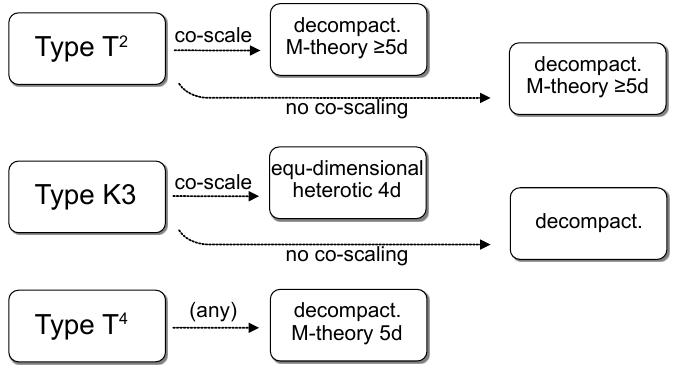
Figure 2 . Basic infinite distance limits in the quantum Kähler moduli space for Type IIA string theory on a Calabi-Yau three-fold. All further possible limits are decompactifications